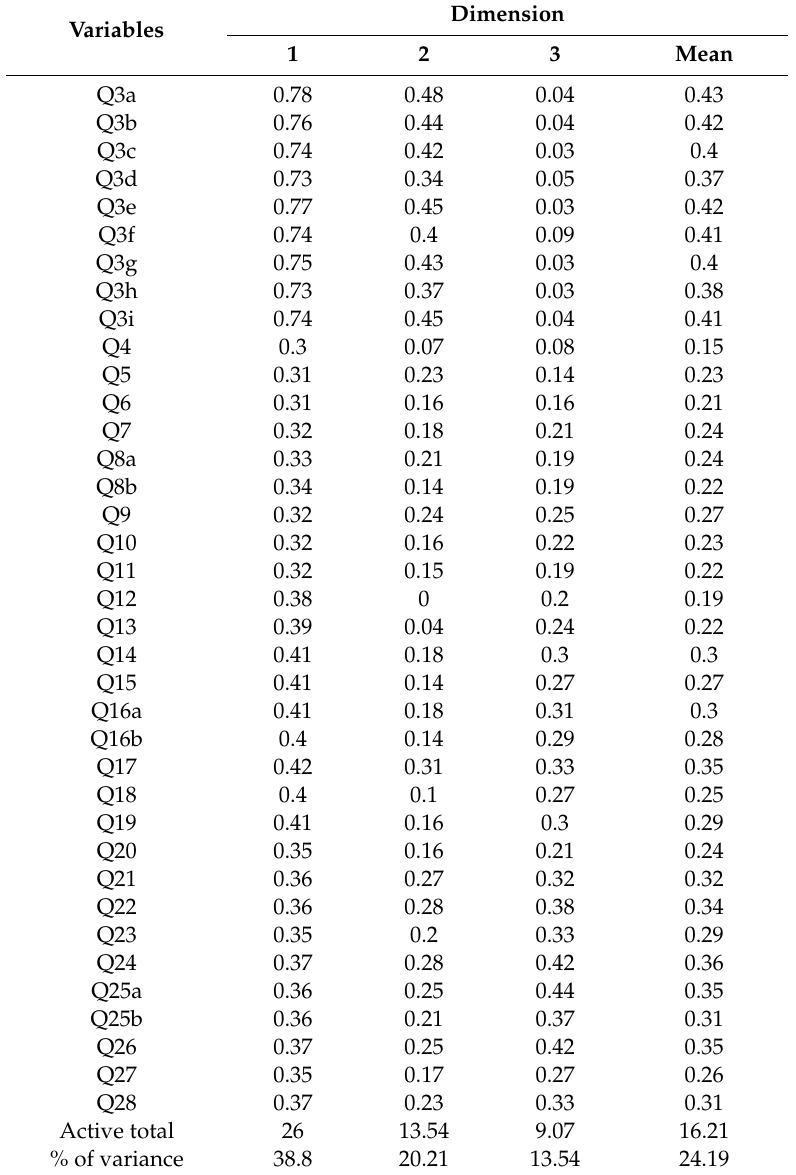
Abbreviations: Please see Table 3 and Table A1—Appendix